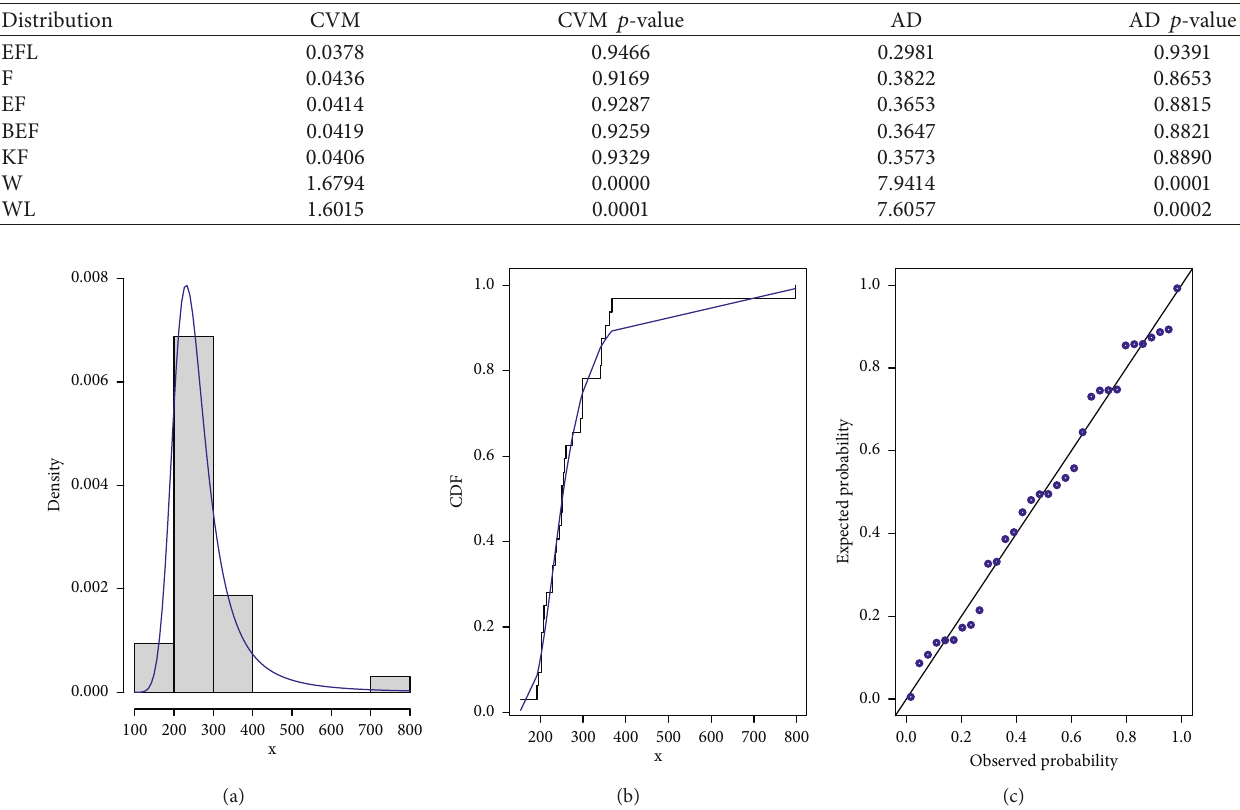
Table 10: Goodness-of-fit measures of estimated distributions for collision data.